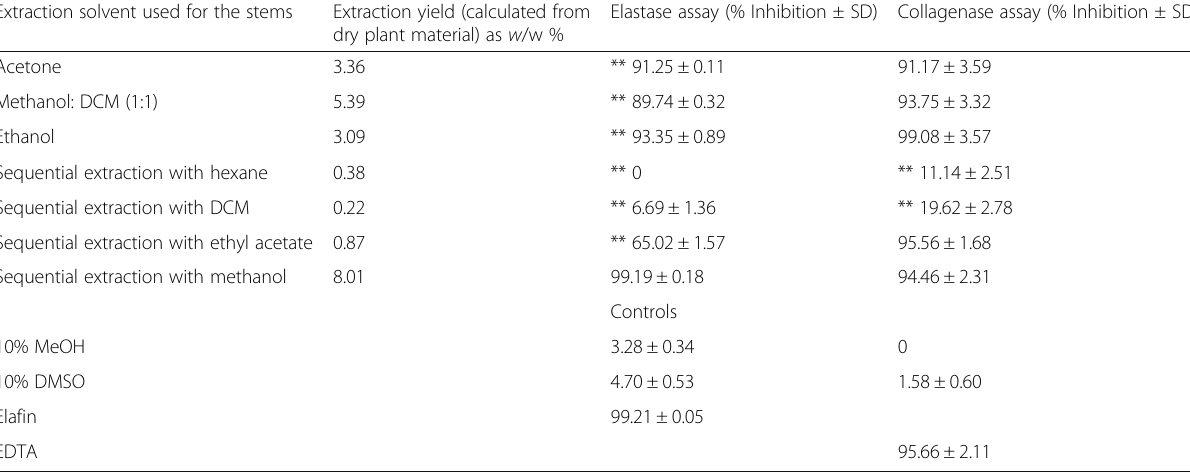
** showing a significant difference of p <0.01 with EDTA